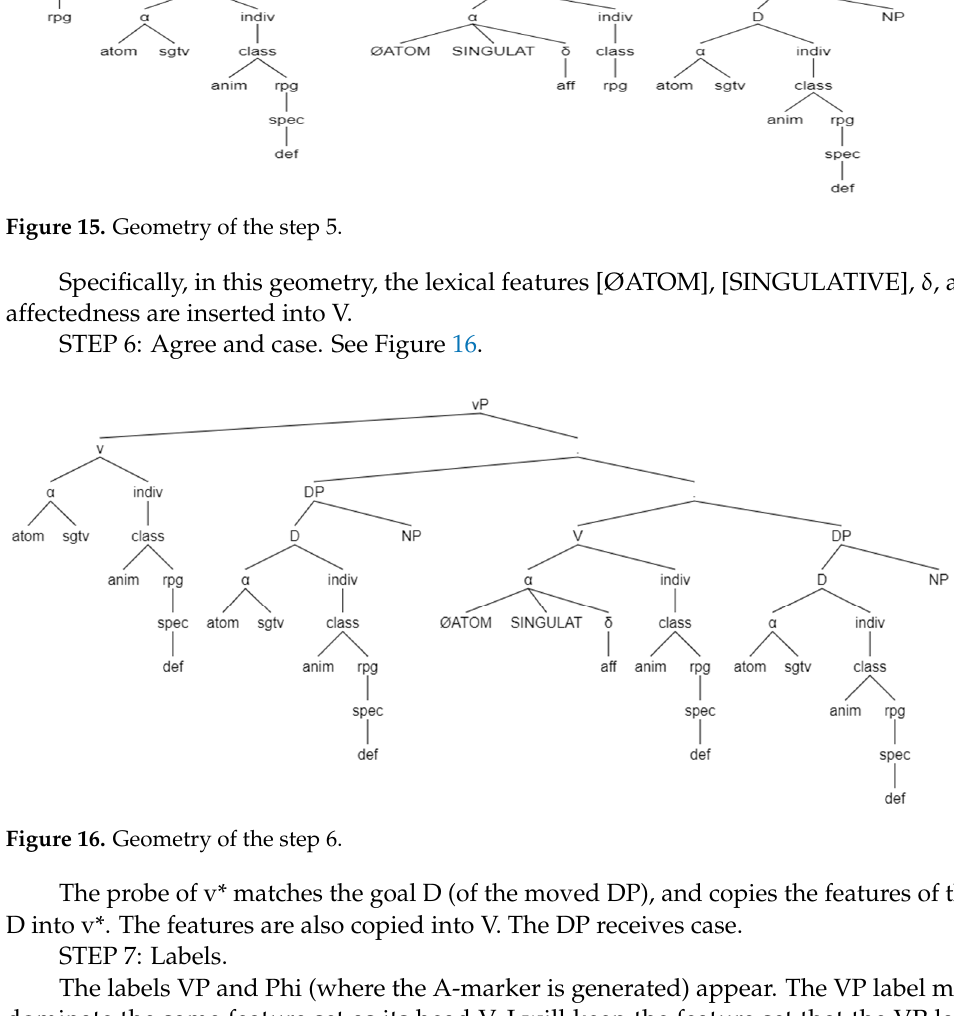
Figure 16. Geometry of the step 6.